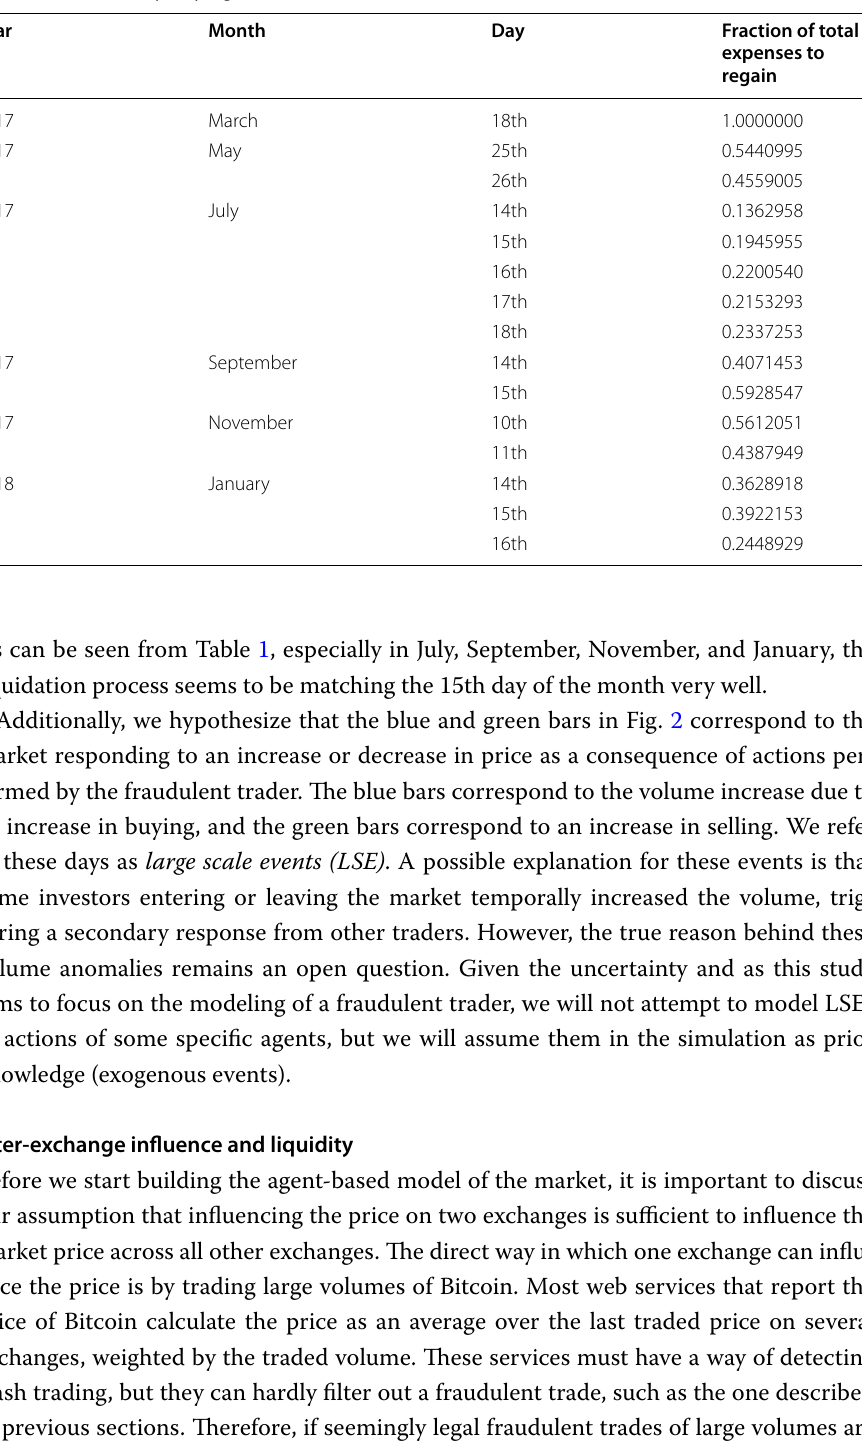
Table 1 List of EoM events and amount of cash planned to obtain at given day in order to cover the expenses incurred by buying